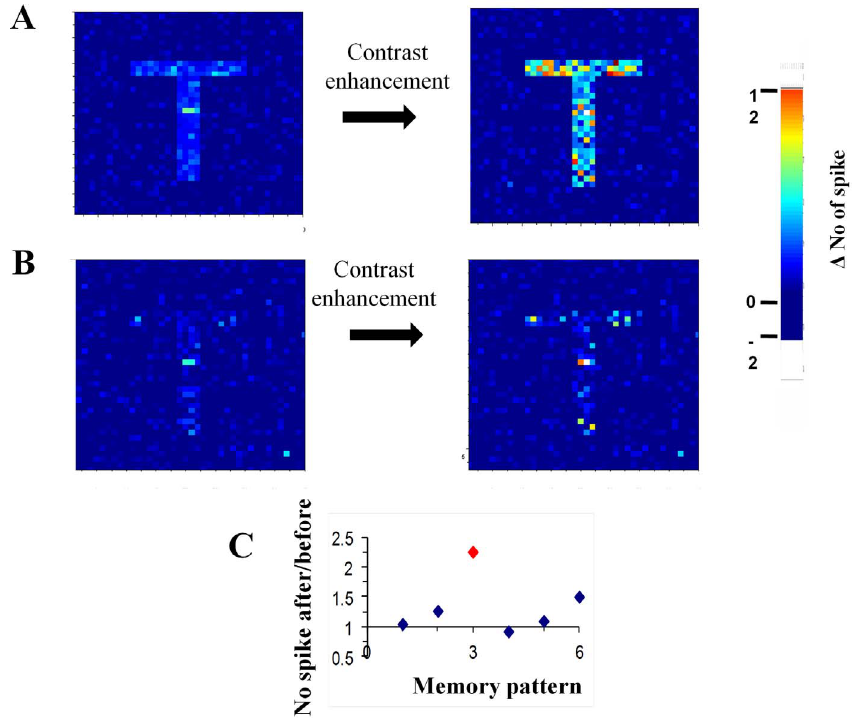
Figure 4. Contrast-enhancement causes selective memory enhancement. Cells in the network were arranged in a matrix in which the intensity level corresponds to the change in the number of spikes during memory activation compared to background. Cells that responded to an arbitrary input-X were arranged in T-shape. A. Contrast-enhancement applied to neurons constructing pattern X, substantially increased their response intensity to the input-X, but activity did not spread to neurons out of this pattern (the same neurons are activated before and after contrast enhancement is applied). B. Contrast enhancement of pattern X did not affect the intensity of another memory-pattern induced by a different input, although the two memory-patterns had a considerable overlap (correlation of 0.74). Notice the vague shape of the T pattern. C. The ratio between the number of spikes before and after contrast-enhancement in response to different inputs. Only the response to input-X (red) was considerably enhanced. Pattern # 6 is shown in figure